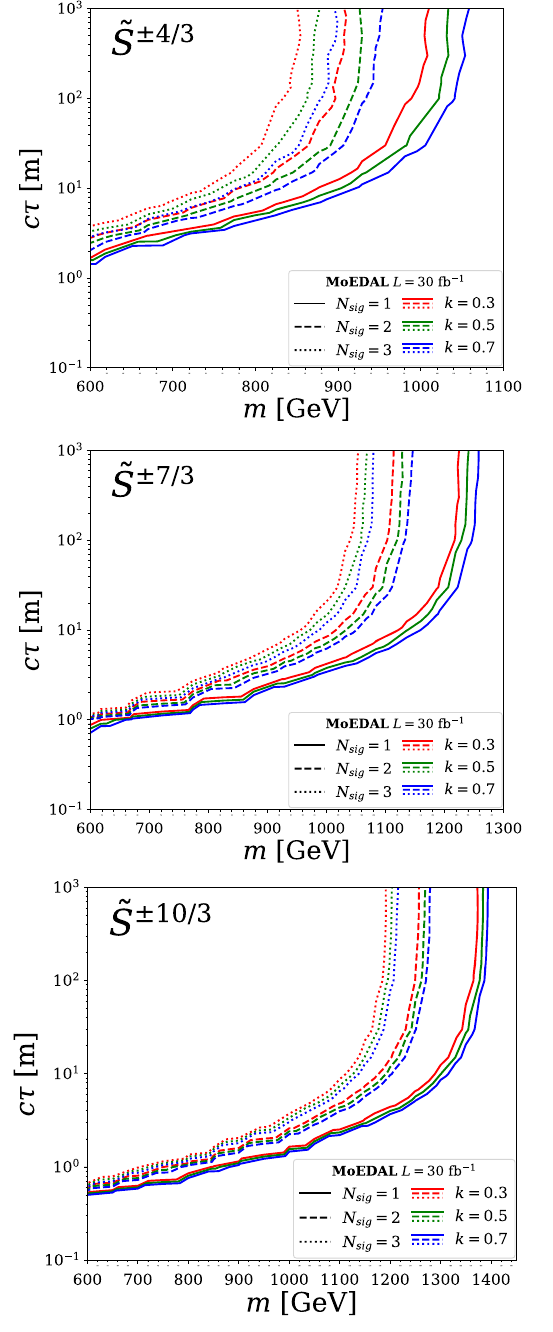
Fig. 9 The model-independent detection reach at MoEDAL in the ( m , c τ ) parameter plane for individual particles of Model-2. The red, green and blue contours correspond to the results obtained with the hadroni-